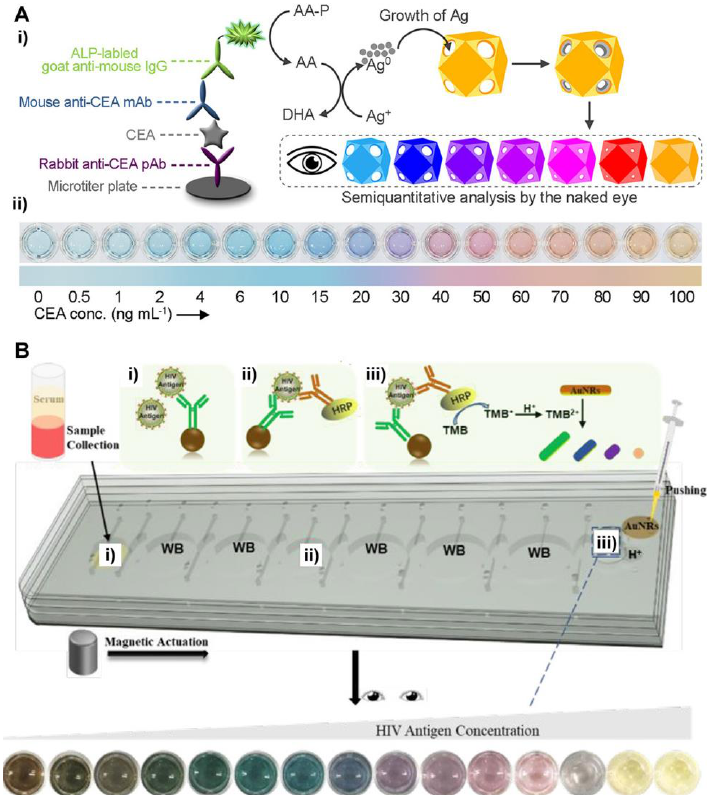
Figure 7. Label-free colorimetric NM NPs-based POC tests. ( A ) Au/Ag alloyed nanocages as label- free colorimetric reporters for detection of CEA: (i) schematics showing the sensing principle. ALP: alkaline phosphatase; AA-P: l-ascorbic acid 2-phosphate; DHA: l-dehydroascorbic acid; (ii) detec- tion results of CEA standards. Adapted with permission from ref [82]. Copyright 2021 American Chemical Society. ( B ) Au nanorods (Au NRs) as label-free colorimetric reporters for detection of HIV antigen: (i – iii) working principle of the Au NRs-based, microfluidic-integrated multicolor im- munosensor for HIV antigen detection. Adapted with permission from ref [83]. Copyright 2020 American Chemical Society.